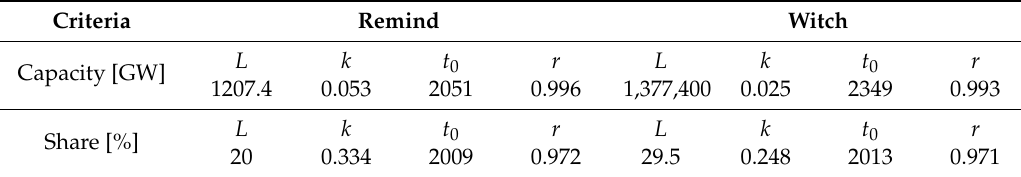
Figure 8. Europe wind technology capacity development based on the reference scenario based on the reference scenario of WITCH until the year 2100 (own work).